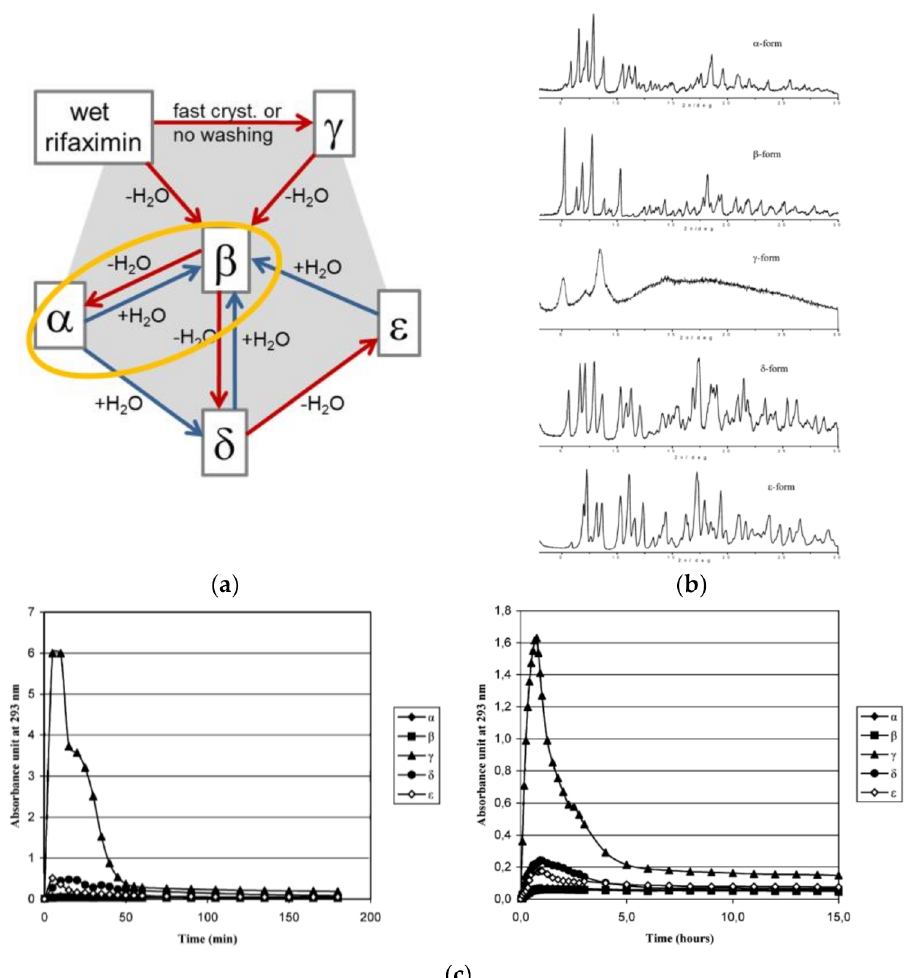
Figure 17. ( a ) The intricate hydration/dehydration phase relationship between the various forms of Rifaximin, ( b ) the powder X-ray diffraction patterns five forms of Rifaximin, ( c ) dissolution rates of Rifaximin hydrates at 250 ( left ) and 100 ( right ) rpm of mixing rate. Time vs. absorbance at 293 nm. Reproduced with permission from [63,64].